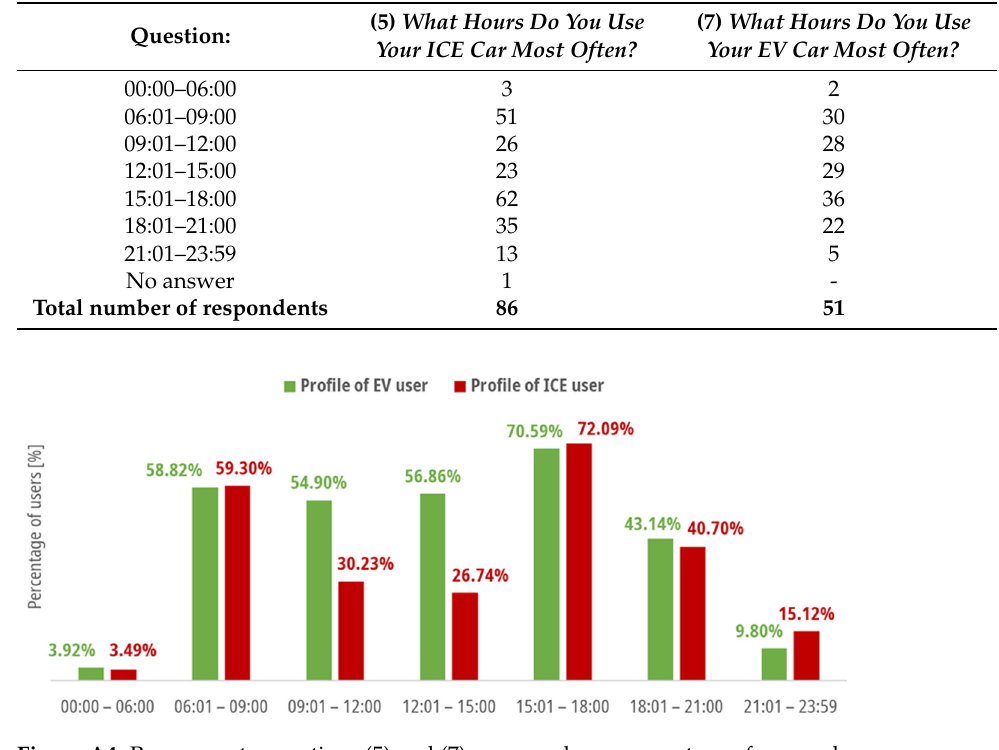
Figure A4. Responses to questions (5) and (7) expressed as a percentage of responders.